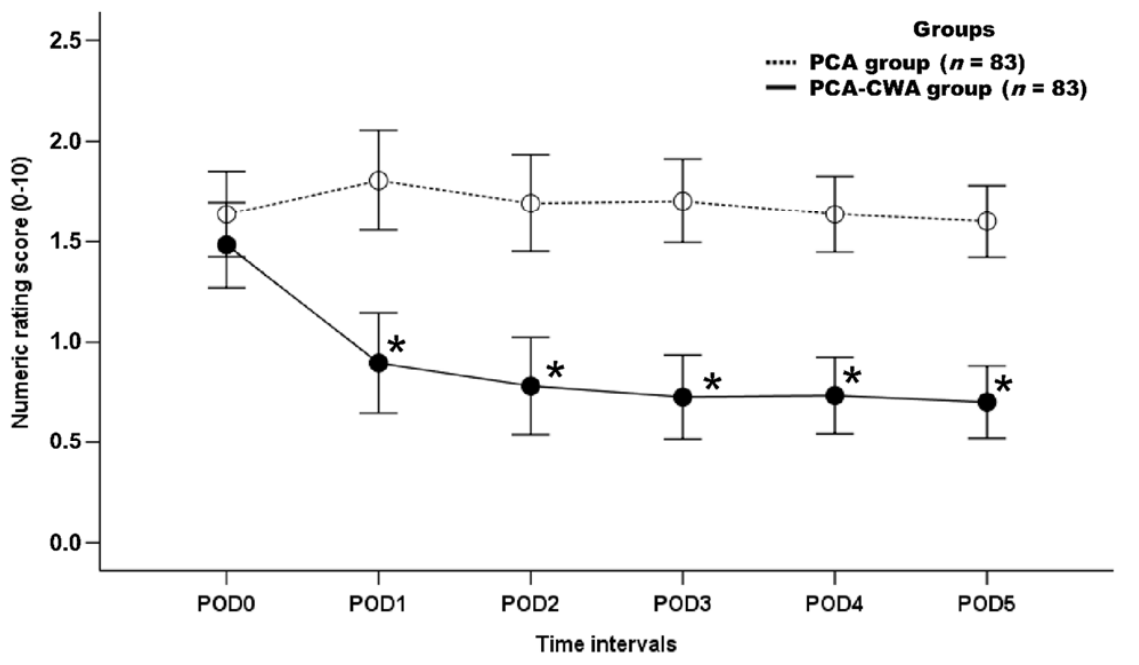
Figure 3. Numeric rating score at postoperative day 5, after propensity score matching. POD, postoperative day; POD0, day of surgery. PCA group, group of patients who received postoperative intravenous PCA alone; PCA-CWA group, group of patients who received postoperative intravenous PCA and continuous wound infusion analgesia. * p < 0.05 was considered statistically significant.